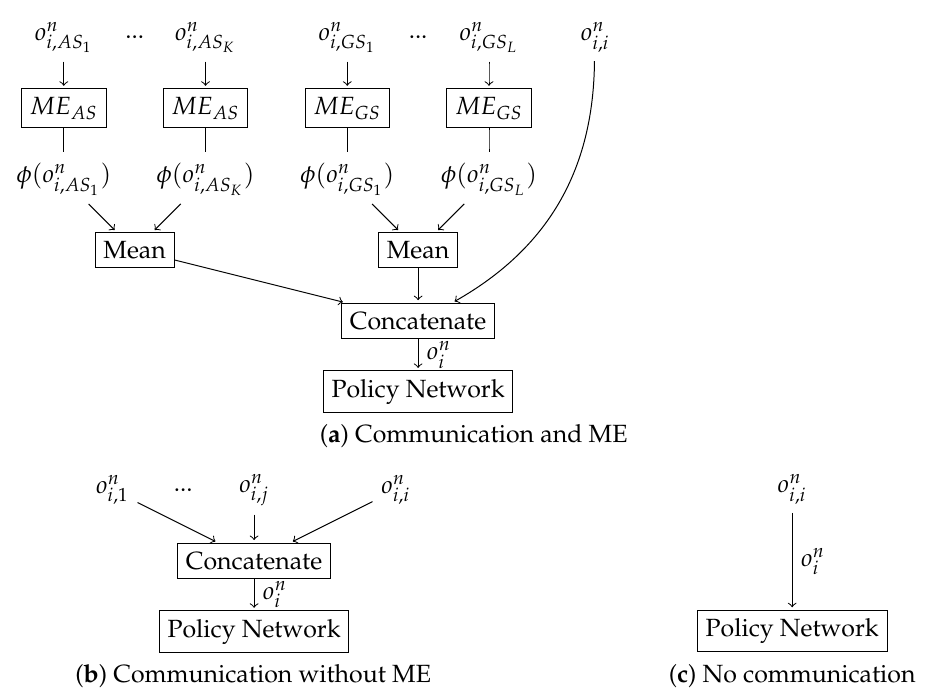
Figure 4. Sketch of the different DLA architectures. The difference in the architectures lies in how the observation o n is obtained. In ( a , b ), there is communication among the swarm agents, and hence, i each agent i has access to the local observations of the rest of the agents. ( a ) shows the architecture when a Mean Embedding is used: we use separate Mean Embeddings for ASs and GSs, and we assume that there are K + 1 ASs (agent i is also an AS), L GSs and that o n of the mean values of the Mean Embeddings and the local information of the agent i . ( b ) shows the architecture when there is communication but we do not use any Mean Embedding: in this case, o n is the concatenation of the observations. ( c ) shows the no-communication case in which only i the local observation is